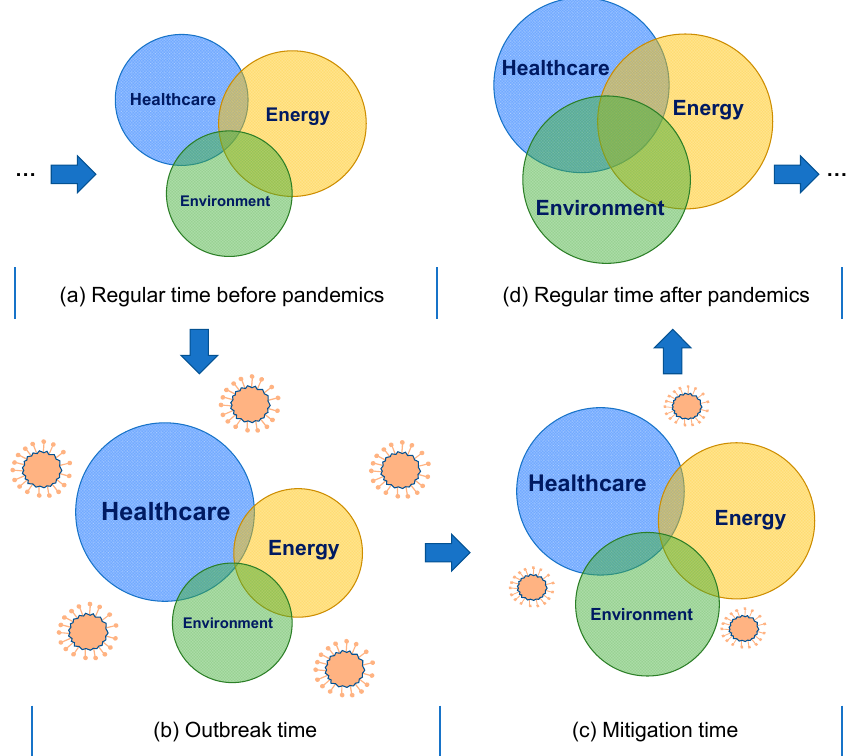
Figure 5. The dynamics of the attention to healthcare, energy and environment triggered by COVID- 19. Note: The discussed attention in this study is in view of decision-makers. In Figure 5a–c, the circle size denotes the paid attention qualitatively, and the overlapping areas in the figure denote the relative attention for issues in the cross-sections. The diagram in Figure 5d is presented with some projection and expectation for the future scenario.